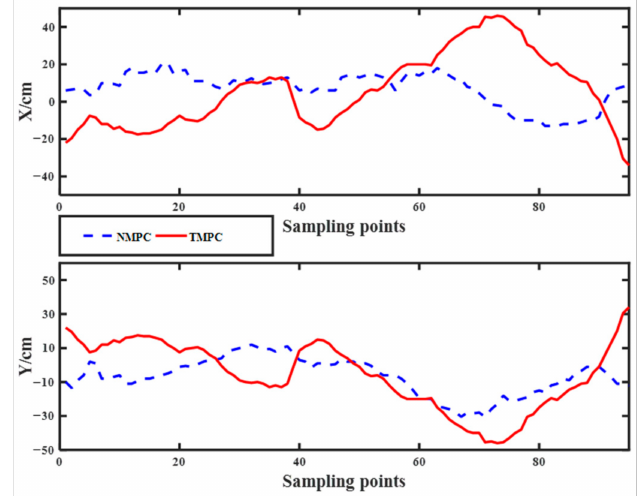
Figure 18. The tracking errors of x and y for the two MPC controllers under DCTR.